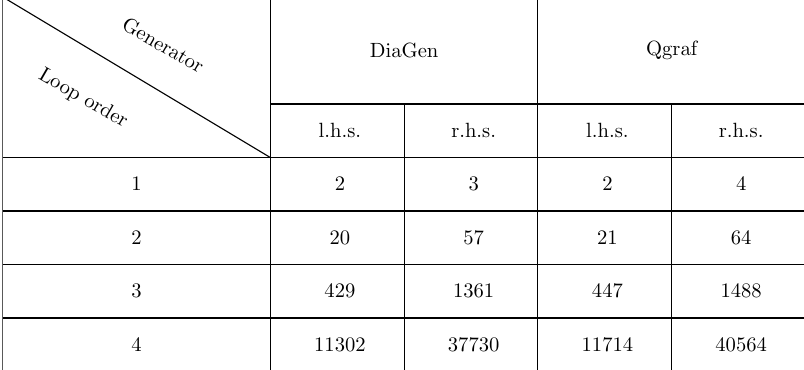
by the diagram generator DiaGen [55], 7 based on the QCD Lagrangian supplemented by two additional local composite operators as discussed in section 2. The numbers of generated diagrams are listed in the second and third column of table 1 for the